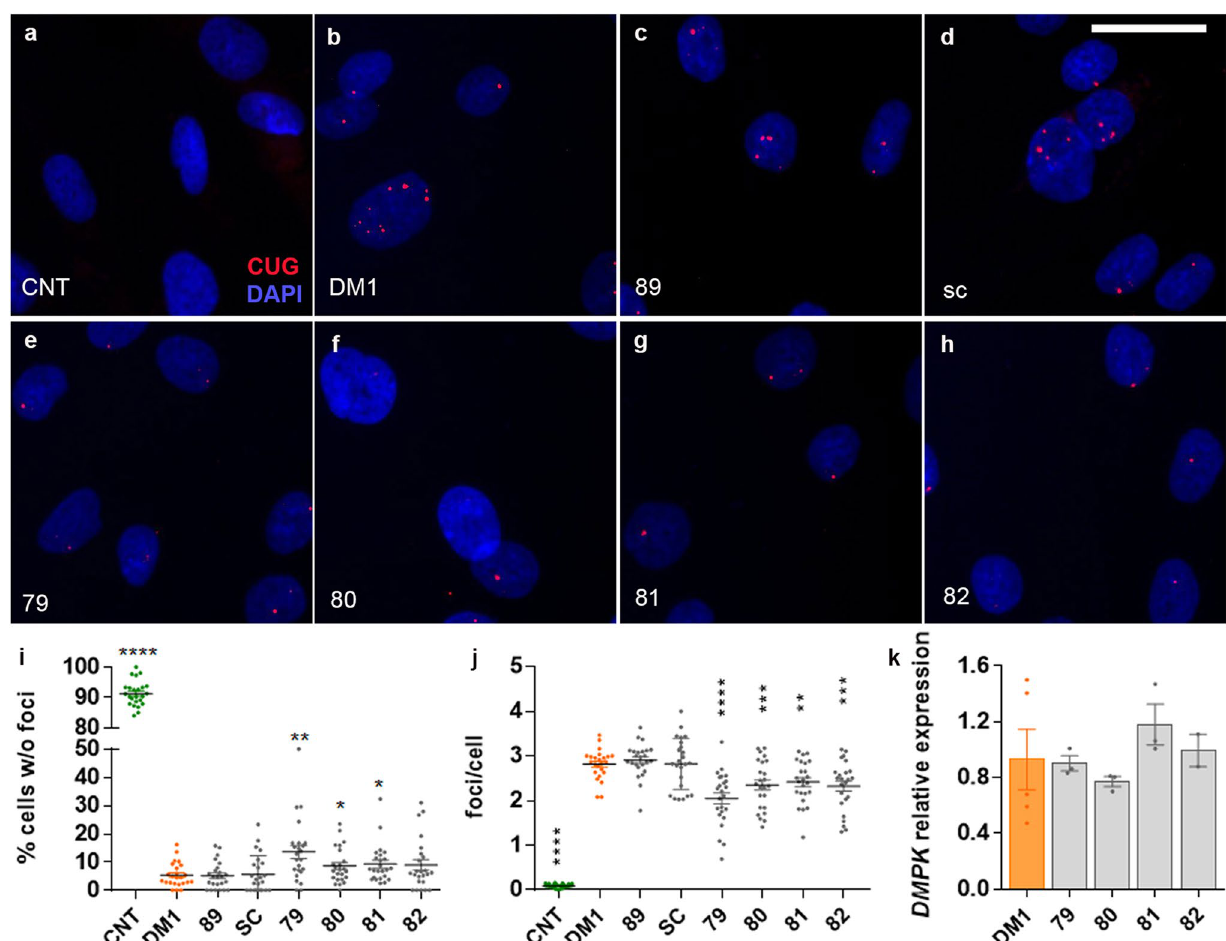
Figure 3. Candidate peptides reduced ribonuclear foci in DM1 cells. Representative micrographs of foci in control (CNT, a ; without DMSO), DM1 (DMSO 0.1%, b ), and DM1 cells treated with negative control (peptide 89 or scrambled peptide (SC); c , d ) or candidate peptides ( e – h ) obtained with an IN Cell Analyzer high-content imaging system (three biological replicates and three technical replicates per biological sample were performed in each condition. Four different fields were analyzed in each sample). Accumulation of mutant transcripts was detected using fluorescent in situ hybridization (FISH) with a Cy3-labeled RNA probe (red dots). Nuclei were counterstained with Hoechst 33258 (blue). Quantification of the images revealed that peptides 79, 80, and 81 significantly increased the percentage of cells without foci ( i ) and reduced the number of foci per cell, in this case including peptide 82 ( j ). The observed reduction in mutant DMPK accumulation was not due to the repression of the DMPK gene expression itself, which was quantified by real-time PCR using primers against a non-repetitive sequence and was found not significantly different from DM1 controls (three biological replicates and three technical replicates per biological sample were performed; k ). *p < 0.05, **p < 0.01, ***p < 0.001 according to Student’s t-test. Scale bar ( a – h ) measures 20